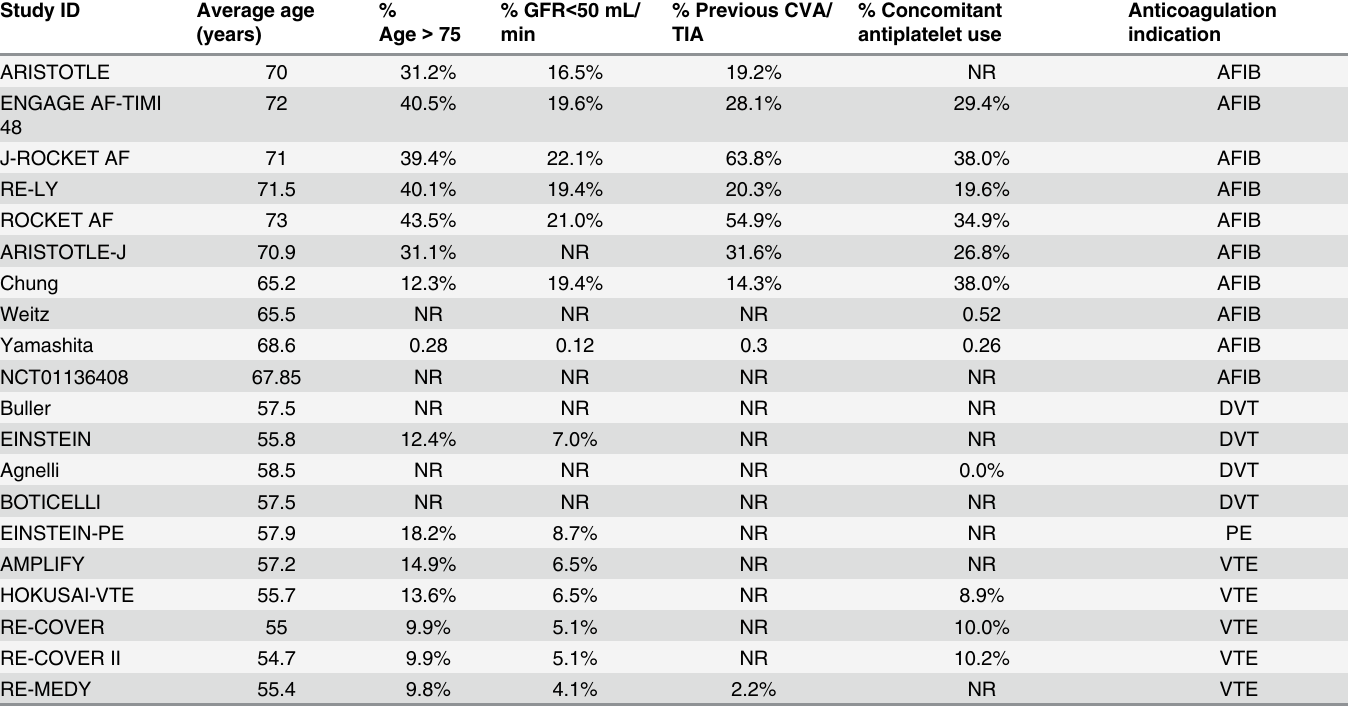
Table 2. Baseline characteristics of included studies. Percentages represent the proportion of patients in each study with the given characteristic. Values are given for all study participants, not exclusively those who had major bleeds. Study